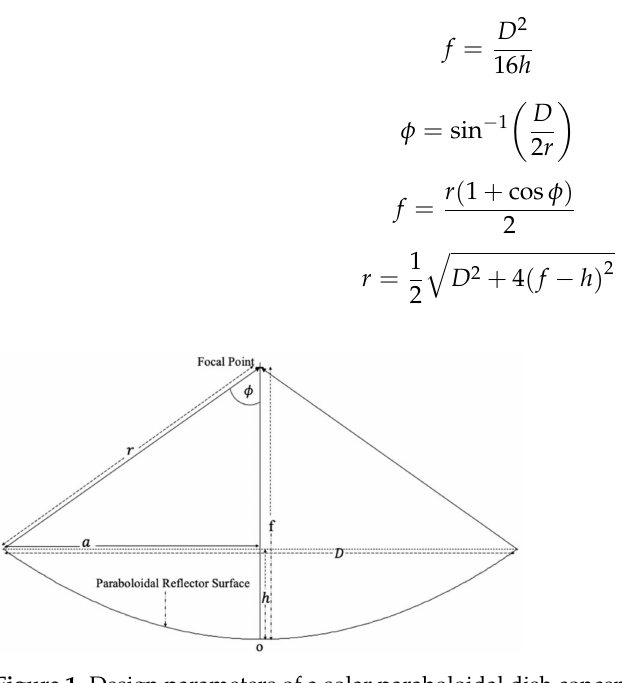
Figure 1. Design parameters of a solar paraboloidal dish